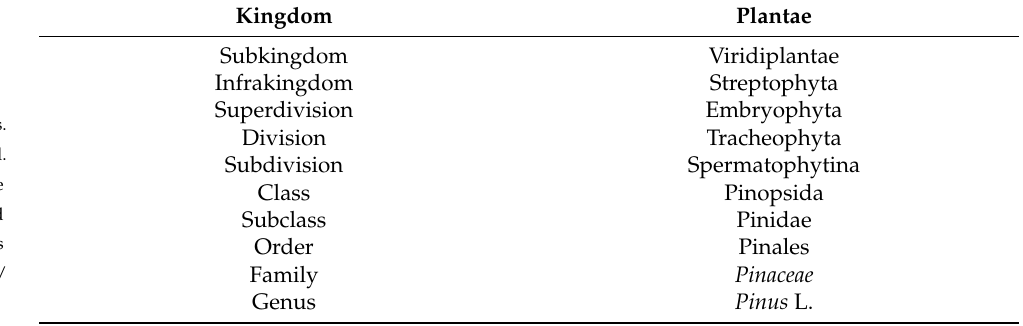
Table 1. Taxonomic hierarchy of genus Pinus L.